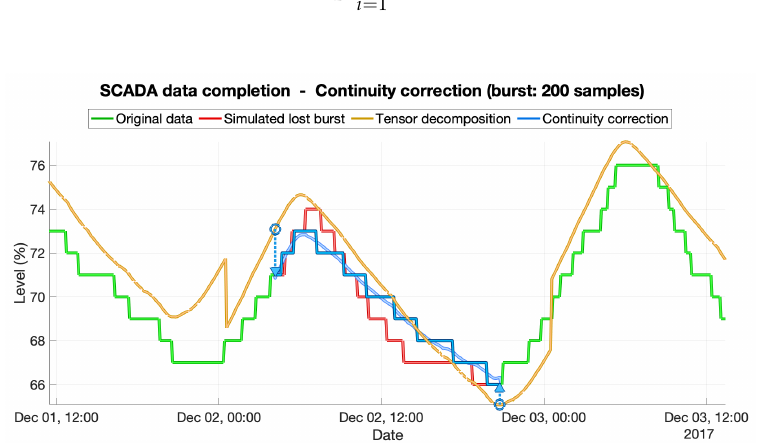
Figure 7. Un example of the continuity correction method. The green line is the original data, x i . The red line shows the 200 samples burst of simulated lost data. The Tucker decomposition (1,1,1) is used. The orange line is the result of the tensor process with this configuration, ˆ x i . The blue arrows indicate the initial and the final offsets, O 0 and O B + 1 . The soft blue line shows the effect of the continuity correction , ˜ x i and the strong blue line indicates the final signal reconstruction, which is adapted to the sensor resolution of